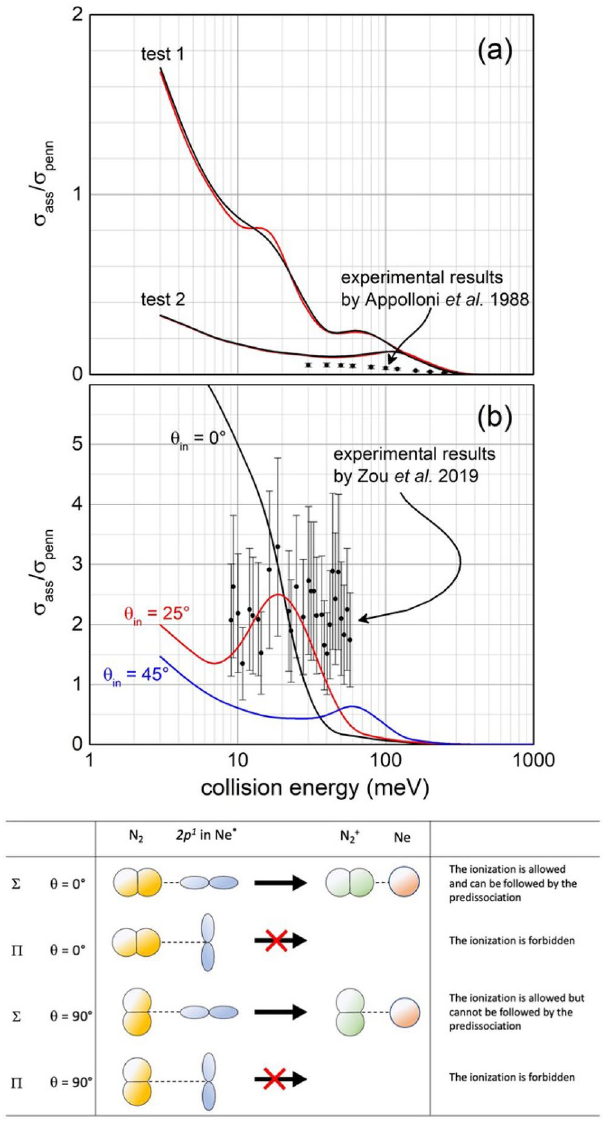
Figure 5. ( a ) Comparison of predicted associate/penning branching ratio (see text) with experimental data from Perugia laboratory 32 . ( b ) Comparison of an exclusive concerted flip mechanism (see text) with data from Lausanne laboratory corrected for predissociation 24 . In such panel, the role of the initial molecular orientation is emphasized; as in Fig. 4, marked red and black lines indicate the calculations performed in the case of collisions involving the 3 P 2 and 3 P 0 spin–orbit states of Ne * , respectively. Lower panel : A schematic view of precursor state structures promoting reaction and associated ion formation. Note that while the half-filled p orbital of Ne * atom exhibits a nodal plane, the HOMO orbital of N 2 from which the electron is removed, does not exhibit any nodal plane perpendicular to the bond axis and passing for its center of mass 33 . Therefore, in the second and fourth cases, characterized by overlap null between orbitals exchanging the electron, the ionization by direct mechanism is forbidden and the reaction can occur only by indirect mechanism (see